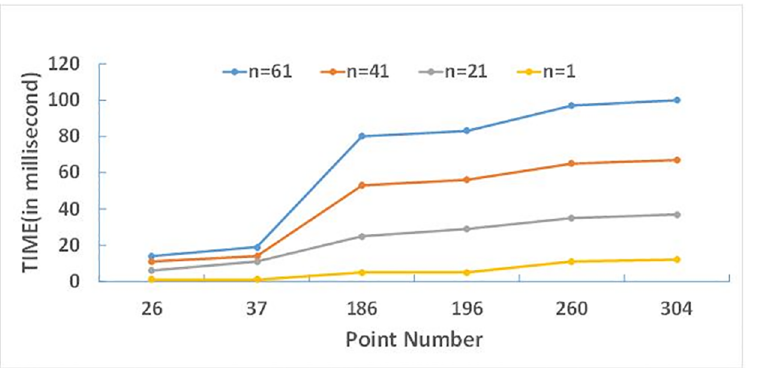
Fig 7. The relationship of time consumption and the number of point